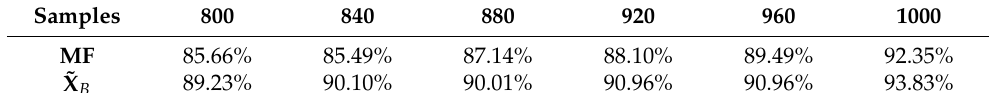
Table 10. Classification accuracy based on different input datasets under EOC.